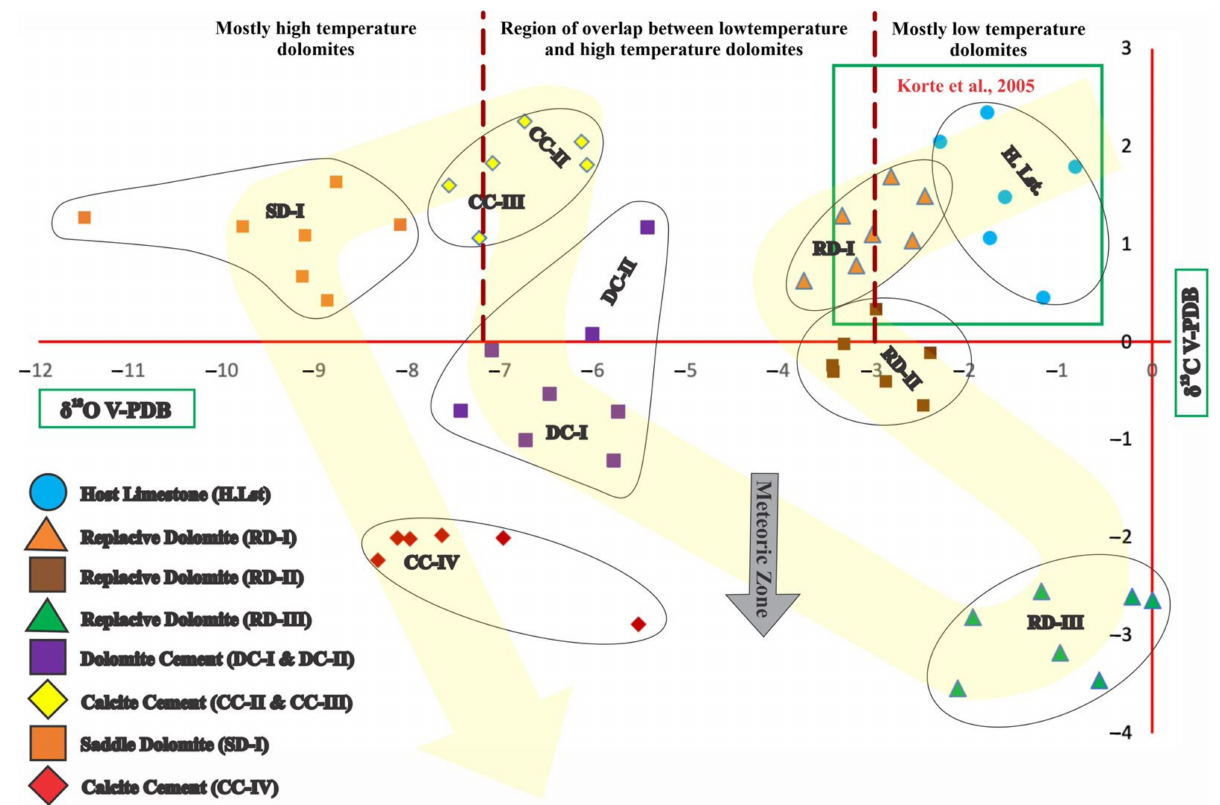
Figure 7. Stable carbon and oxygen isotopic composition cross plot of the precursor limestone and different dolomite phases on the diagram of Allen and Wiggins [58]. The green box indicates the original marine signatures of Late Triassic age [59].